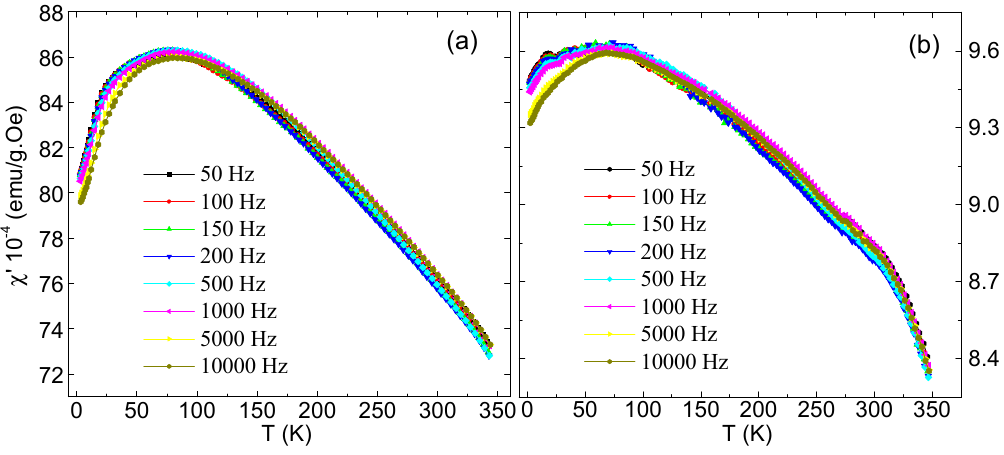
Figure 8. Temperature-dependent AC susceptibility (real part) for ( a ) SrFe 12 O 19 and ( b ) Sr 0.9 Mn 0.1 Fe 11.9 Y 0.1 O 19 .